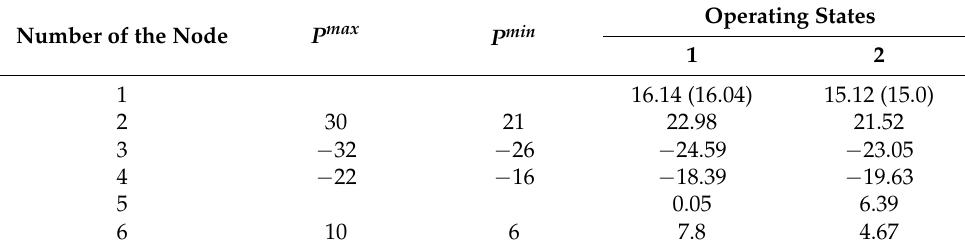
Table 1. Initial information (MW).